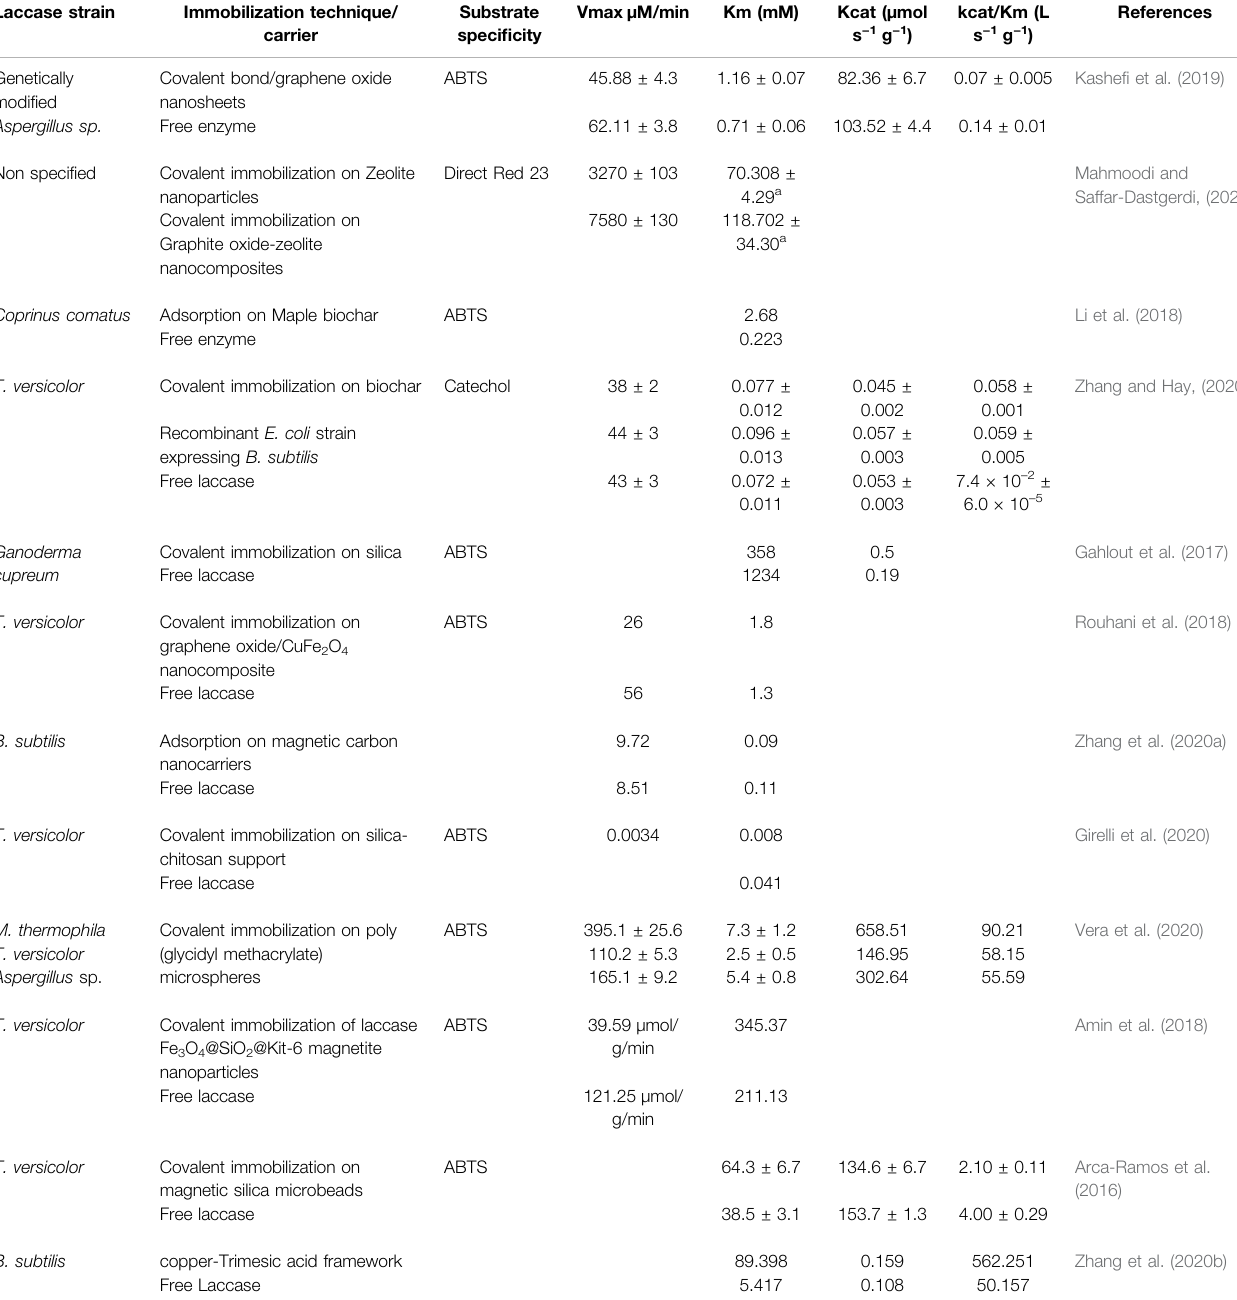
TABLE 6 | Kinetic parameters related to different immobilization techniques and carriers used. Laccase